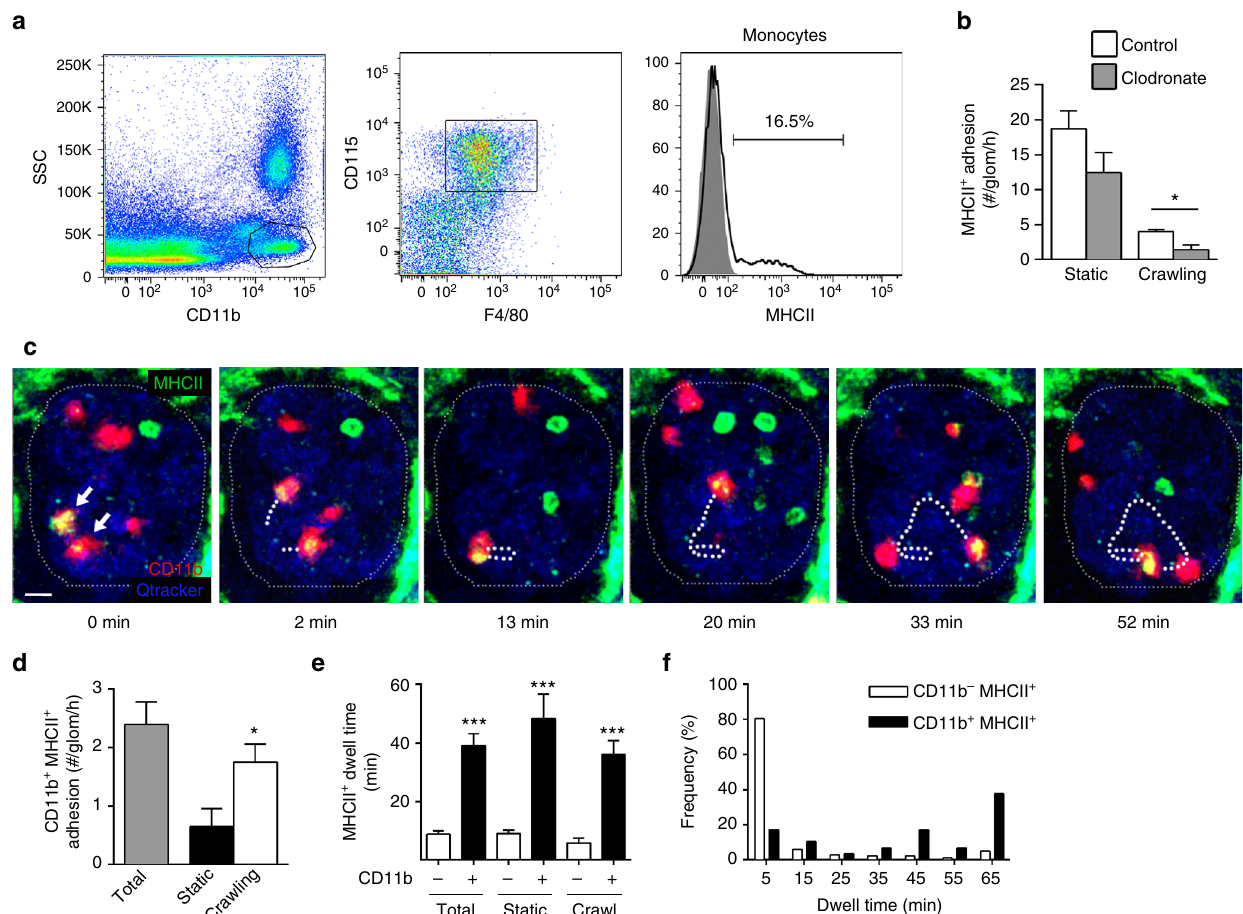
Fig. 6 MHCII-expressing monocytes have prolonged retention in the glomerular microvasculature. a The proportion of monocytes expressing MHCII was determined by fl ow cytometric of circulating leukocytes from MHCII-EGFP mice. The SSC lo CD11b hi population was gated (left panel), then monocytes were identi fi ed as CD115 + F4/80 + (middle panel) and the proportion of MHCII-EGFP + monocytes gated on a histogram (right panel, black line) against a fl uorescence-minus-one control (shaded). Results shown are representative of analyses from three mice. b Effect of clodronate liposomes on adhesion of MHCII-EGFP + leukocytes in glomerular capillaries assessed by intravital multiphoton microscopy analysis of MHCII-EGFP + leukocytes 18 h after treatment with either clodronate (gray bars) or control liposomes (white bars). Data show number of adherent cells de fi ned as either static or crawling and represent mean ± s.e.m. from n = 6 mice per group. * P < 0.05 vs Control. c – f Intraglomerular migration of MHCII-EGFP + CD11b + cells as assessed by intravital multiphoton microscopy. c Multiphoton microscopy image sequence showing the migration paths of two MHCII-EGFP + CD11b + leukocytes (yellow cells, white arrows). Dotted lines show the cell migration paths. Time elapsed is indicated below panels. See also Supplementary Movie 10. d Number of adherent MHCII-EGFP + CD11b + cells, shown for total cells, and separately for static and crawling cells. * P < 0.05 vs ‘ Static ’ . e Dwell time for CD11b − MHCII + and CD11b + MHCII + cells, shown for total cells and separately for static and crawling cells. *** P < 0.001 vs corresponding CD11b − MHCII-EGFP + populations. f Frequency distribution of the dwell times of CD11b − MHCII-EGFP + vs CD11b + MHCII-EGFP + cells. Data in d – f were derived from n = 4 mice (CD11b + n = 29 cells; CD11b − , n = 181 cells) and are shown as mean ± s.e.m. ( d , e ). b , d , e Mann − Whitney or unpaired Student ’ s t